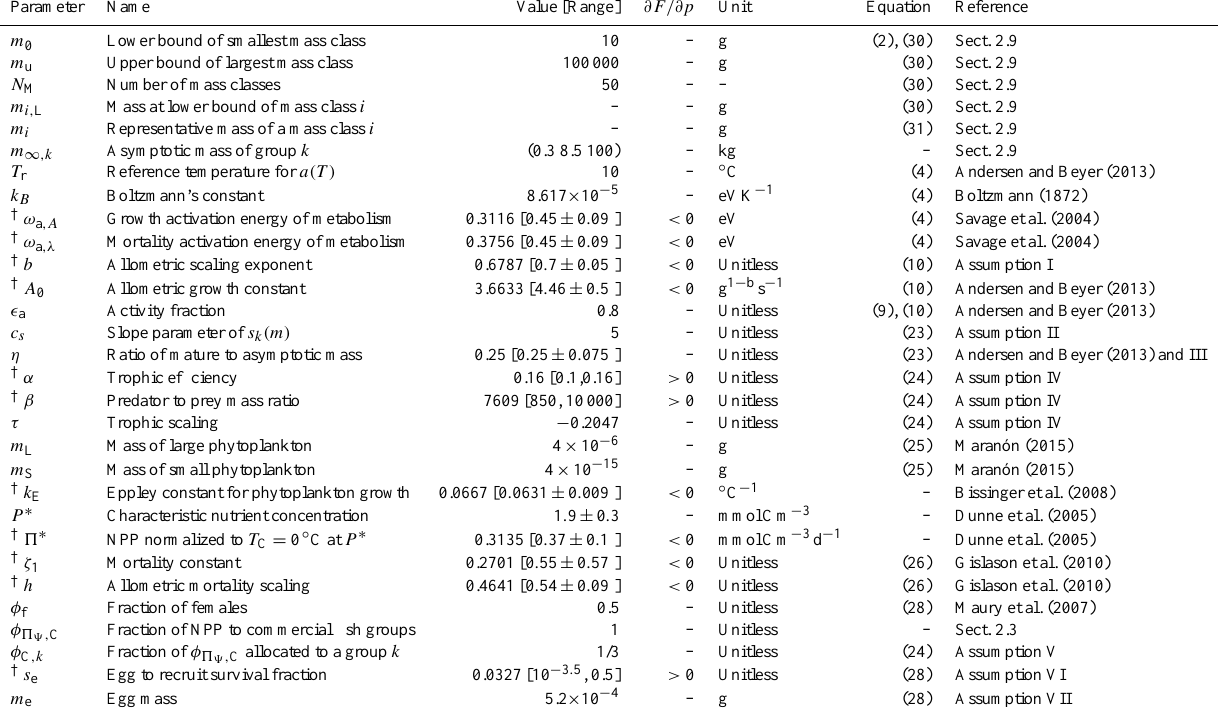
Table 1. Ecological model parameters. Assumption (I) (Brown et al., 2004; Savage et al., 2004; Andersen and Beyer, 2013); assumption (II) value of slope sufficiently large to have abrupt increase in allocation of reproduction from 0 to 1; assumption (III) (Beverton, 1992; Charnov et al., 2012); assumption (IV) (Jennings et al., 2008; Barnes et al., 2010; Irigoien et al., 2014). β truncated since we only consider fish up to 100kg; assumption (V) Equal partitioning of net primary production to each group; assumption (VI) (Dahlberg, 1979; Andersen and Pedersen, 2010; Pulkkinen et al., 2013). Assumption (VII) (Duarte and Alcaraz, 1989; Cury and Pauly, 2000; Freedman and Noakes, 2002; Maury et al., 2007). The † symbol in the first column identifies parameters that were considered in the tuning procedure of the companion paper (Carozza et al., 2016). ∂F/∂p is the rate of change of equilibrium biomass (calculated over the three groups) with respect to change in a parameter p